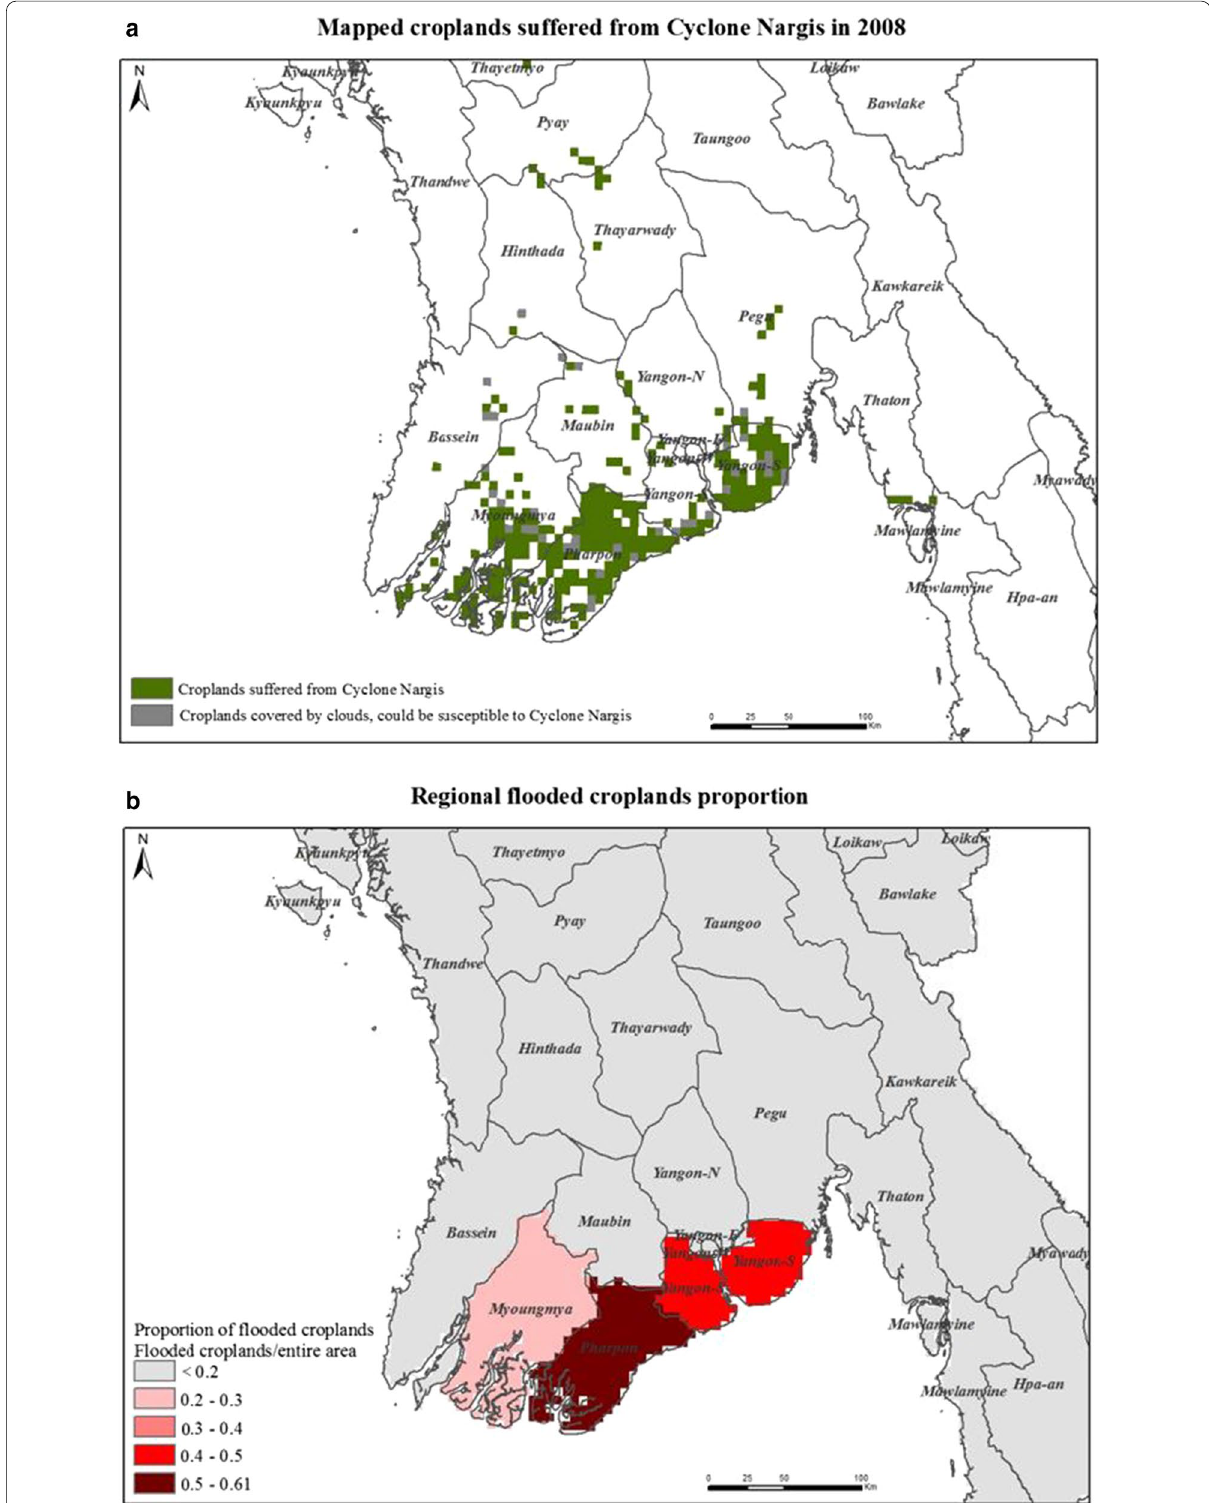
Fig. 7 Impact of the extreme event—Cyclone Nargis: A1a (top figure). Croplands suffered from Cyclone Nargis (2008) in the low-lying delta of Myanmar; A1b (bottom figure) Regional proportion of flooded